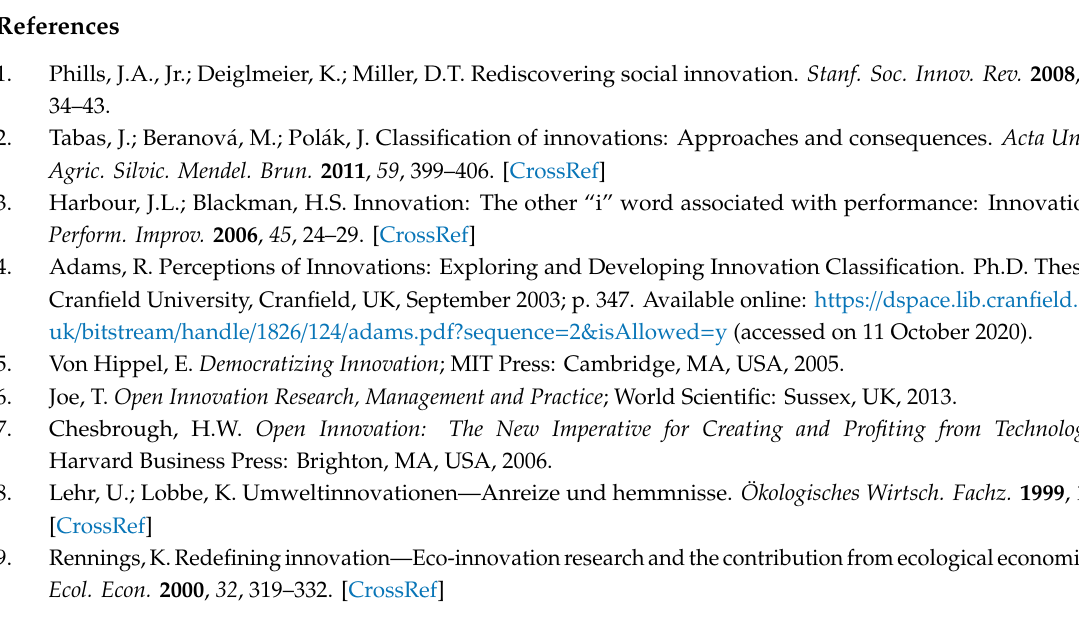
Figure A3. Template for the expression of interest.